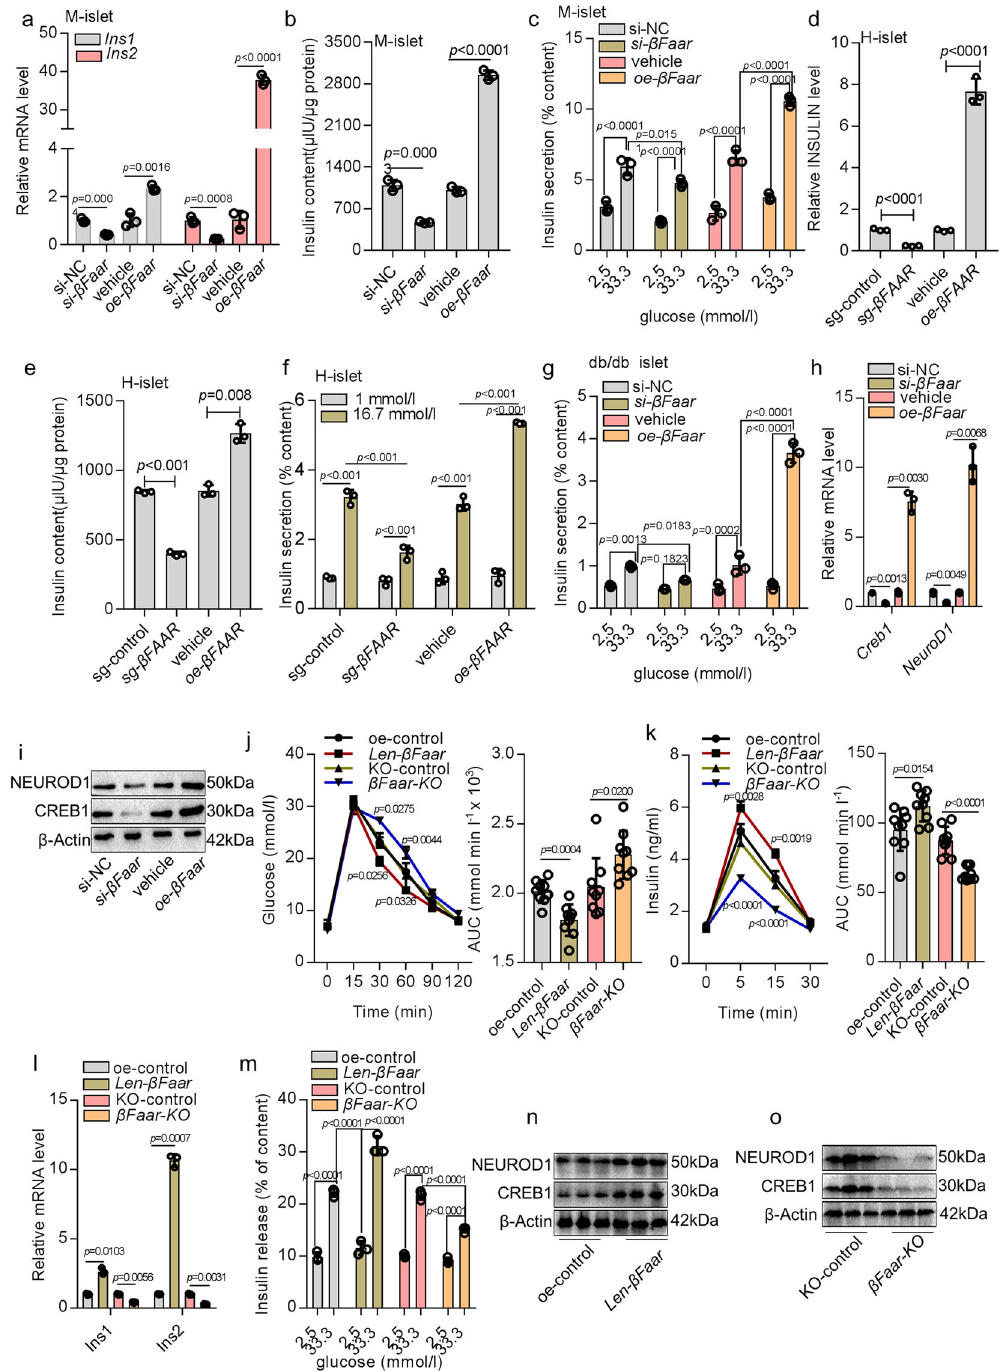
Fig. 3 Suppression of β Faar expression decreases insulin transcription and secretion. β Faar overexpression plasmid ( oe - β Faar ) and β Faar smart silence ( si - β Faar ) were transfected into mice islet cells for 48 h. Then mRNA levels of insulin genes ( Ins1 and Ins2 , a , n = 3) were tested by qRT-PCR, insulin content ( b , n = 5) and insulin secretion was analyzed by ELISA ( c , n = 5). INSULIN gene expression ( d ), insulin content ( e ) and insulin secretion ( f ) in the human islets transfected with oe- β FAAR or sg- β FAAR . Insulin secretion in the primary islets of db/db mice transfected with oe - β Faar or si - β Faar ( g , n = 5, 10 weeks old). The mRNA ( h ) and protein ( i ) level of CREB1 and NEUROD1. j IPGTT (2 g kg -1 ) in overnight fasted Len- β Faar mice and control mice ( n = 9). k In vivo insulin excursions in overnight fasted Len- β Faar mice and control mice after IPGTT exposure ( n = 9). l Relative Ins1 and Ins2 expression levels in vivo ( n = 3). m Static insulin secretion of islets ( n = 5) at indicated glucose concentrations. n – o The protein levels of CREB1 and NEUROD1 in the islets of Len- β Faar mice ( n ) or β Faar-KO mice ( o ) ( n = 5). All experiments above were performed in triplicates, and each group contained three batches of individual samples. The p -values by one-way ANOVA ( b , d , e ), or two-way ANOVA ( a , c , f – h ), and ( j – m ) are indicated. Data represent the mean ± SD, except ( j , k ) (mean ± SEM). Source data are provided as a Source data fi